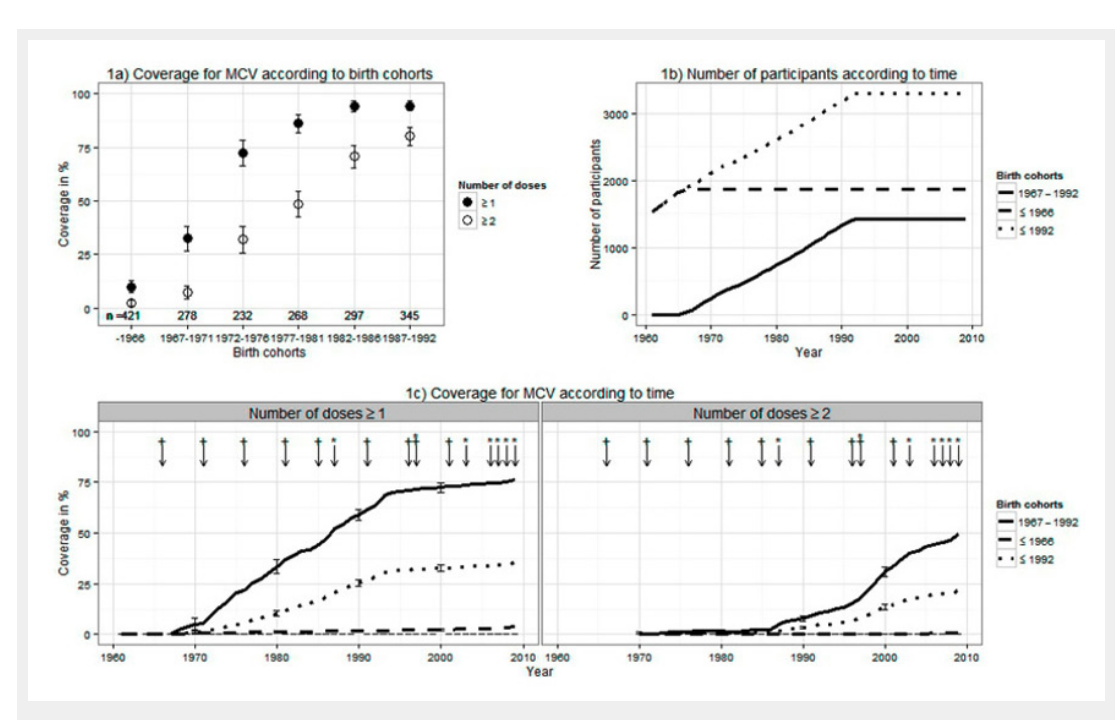
(a) Measles-containing vaccine (MCV) coverage for various birth cohorts at one and two doses; n represents the size of the birth cohort. (b) Number of participants according to year and birth cohort ≤1966, 1967‒1992 and ≤1992. Starting in 1993 the curve is flat since no new participants were considered. (c) MCV coverage over time for birth cohorts ≤1966, 1967–1992 and ≤1992. Arrows labelled with (+) indicate when changes to the measles / measles-mumps-rubella recommendations were made in the Swiss Immunization Schedule and arrows labelled with (*) show the occurrences of large measles outbreaks in Switzerland that were published. The bars on the coverage data represent Wald confidence